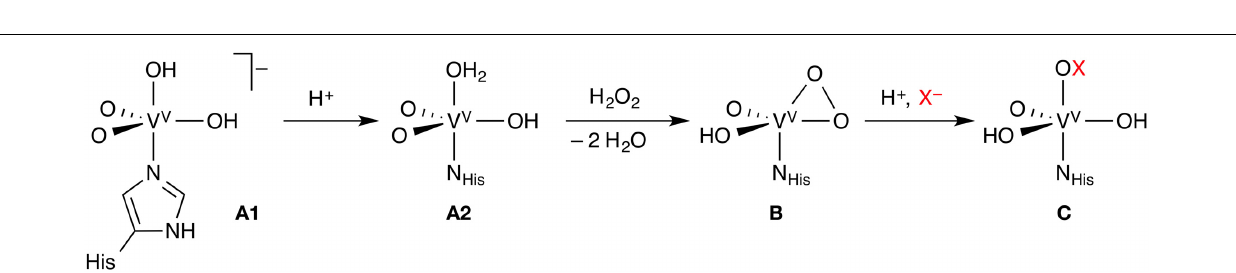
FIGURE 2 | Key steps of the mechanism of vanadate-dependent haloperoxidases. Each complex may exist in different protonation states, only one of which is shown; the exact order of the reaction steps leading from A1 to B is uncertain.